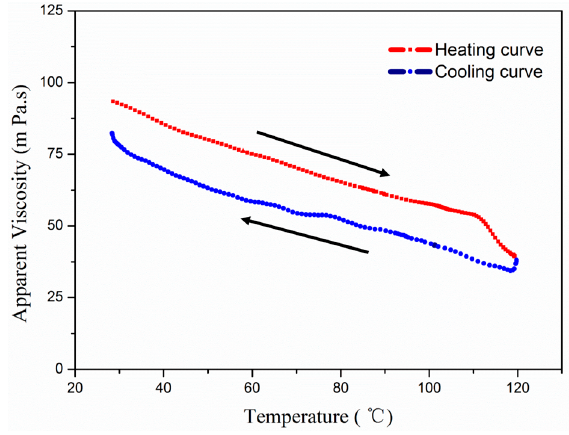
Figure 8. Effect of temperature on the apparent viscosity of PASD in NaCl solution.